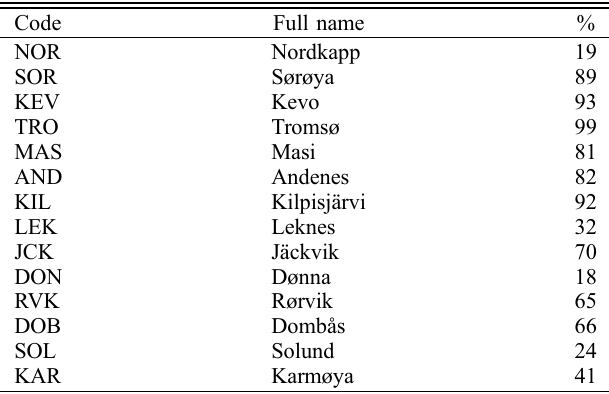
Table 1. Availability of data from IMAGE magnetometre stations used in this study.